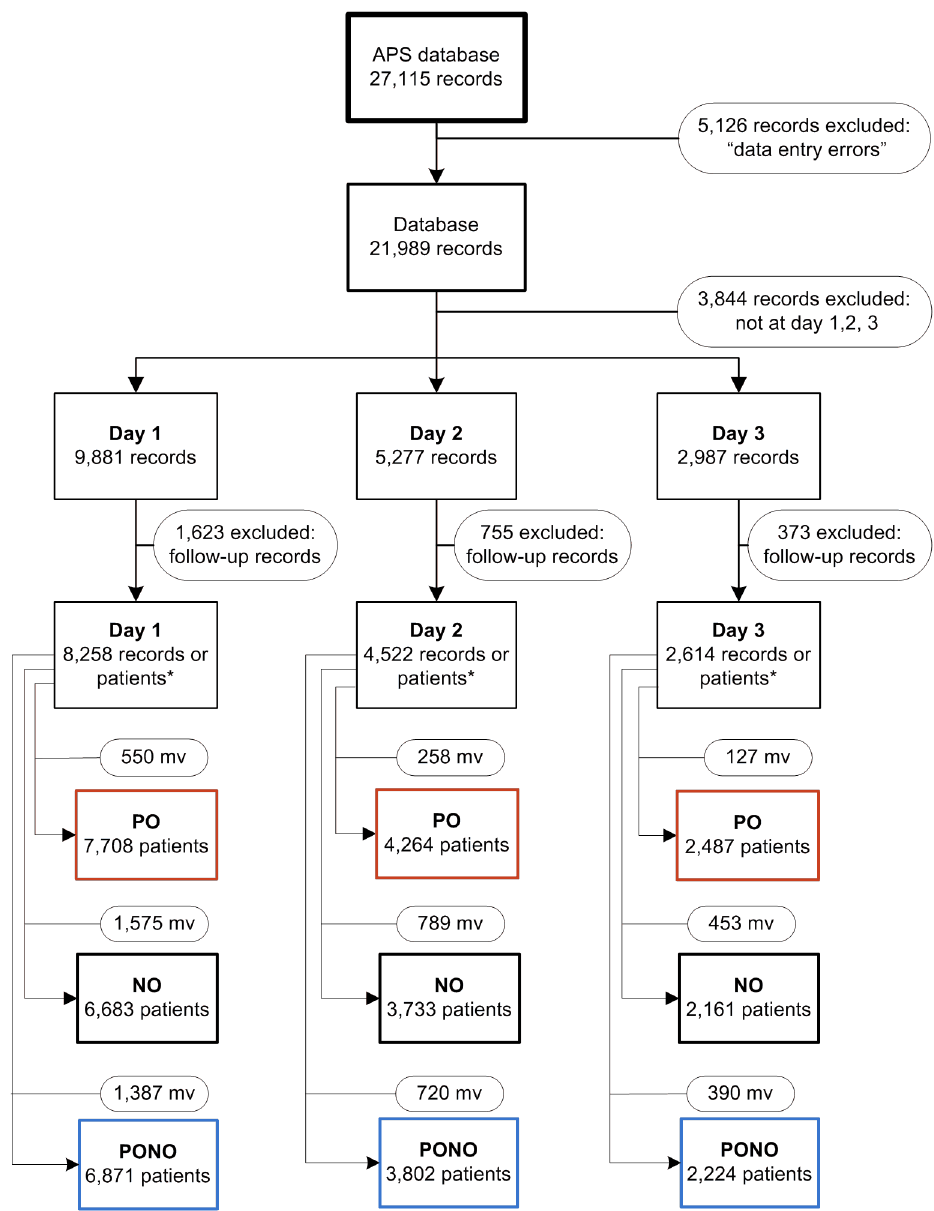
Fig 1. Flow chart: Transforming the database of the Acute Pain Service(APS) into nine data sets. For each of the three postoperative days, three data sets are created: one for patient’s opinion (PO), one for nurses’observation (NO) and one for the combinedvariable(PONO). * Beforethis point multiple records are possibleper patient but after this point the numberof records equalsthe numberof patients. mv = missing